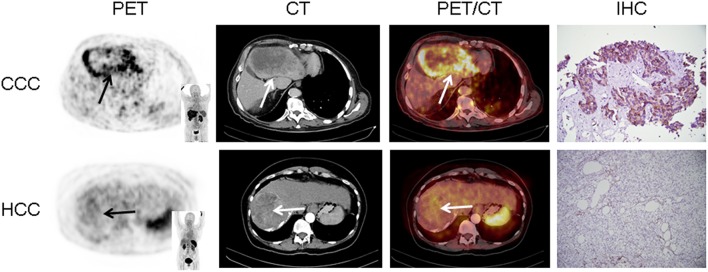
Concordance of immunohistochemistry (IHC) and non-invasive CXCR4-directed positron emission tomography (PET) imaging in patients suffering from cholangiocellular carcinoma (CCC, upper row, patient #7) and hepatocellular carcinoma (HCC, lower row, patient #17). Upper row (patient #7): Display of transaxial PET (left), computed tomography (CT, second panel) and fused PET/CT (third panel) images of a left liver lesion. The lesion demonstrates high CXCR4 expression, which could be confirmed in the surgical specimen after tumor resection (IHC, fourth panel). The immunoreactive score (IRS) was 12 (Table 1). Lower row (patient #17): Display of transaxial PET (left), CT (second panel) and fused PET/CT (third panel) images of the primary. The lesions demonstrates no CXCR4 expression on PET. The patient presented with negative IHC for CXCR4 derived from a surgical specimen (IRS, 0, Table 1). Magnification of IHC: × 400.